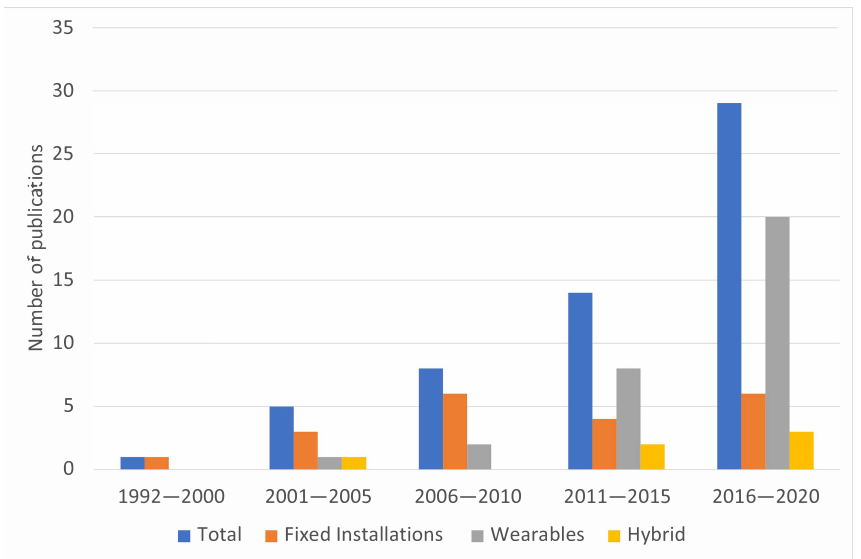
Figure 1. Number of HMP publications since 1992 until 2020.